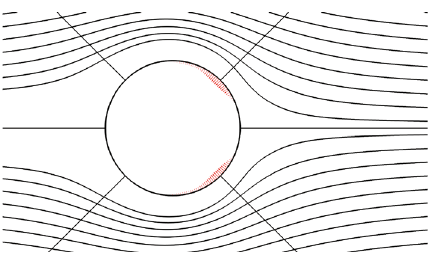
Figure 8: Optimised suction pro fi le at Re = 180 with 6 control segments and streamlines of stabilised fl ow.